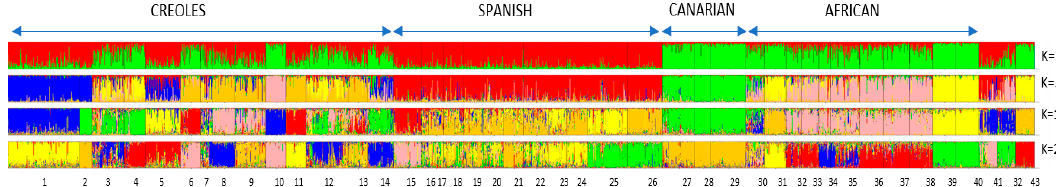
Figure 5. Genetic structure of the 43 goat populations analyzed. Graphical representation of clusters when K = 2, K = 5, K = 18, and K = 25. 1: Chusca Lojana; 2: Galapagos goat; 3: Spanish goat; 4: Myotonic;